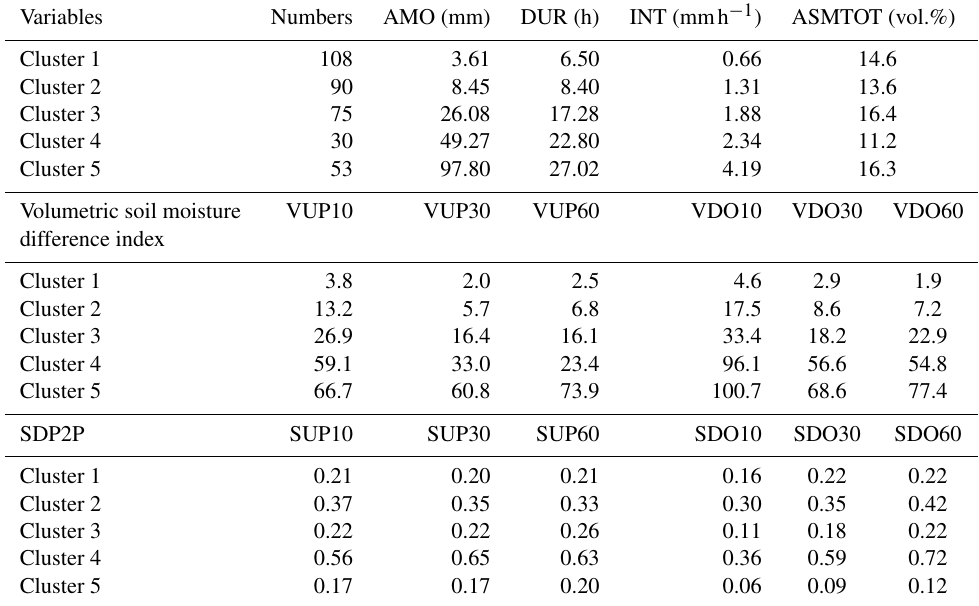
Table 1. Arithmetic averages of SOM inputs for rainfall amount (AMO), rainfall duration (DUR), rainfall intensity (INT), antecedent soil moisture for all points (ASMTOT), volumetric soil moisture difference index, and standard deviation of peak-to-peak time